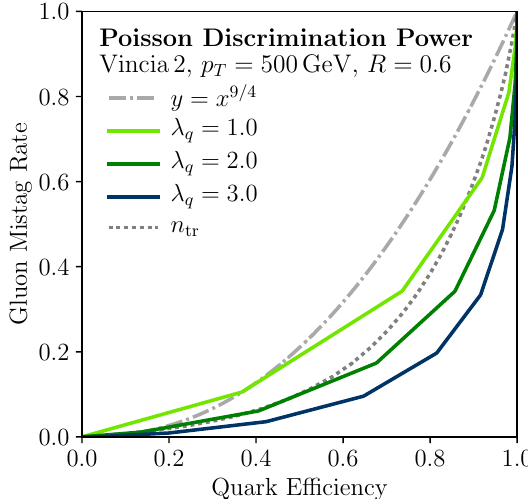
Figure 7. Expected quark/gluon discrimination power for Poisson-distributed observables. The mean observable value for quarks is (cid:21) q , and we assume the mean for gluons is given by Casimir scaling (cid:21) g = ( C A =C F ) (cid:21) q . For reference, we show the y = x 9 = 4 curve for additive observables with Casimir scaling, as well as track multiplicity n tr extracted from Vincia . For mean quark values (cid:21) q & 2, a Poisson-like observable satisfying Casimir scaling would be competitive with track multiplicity. The ROC curves are piecewise linear since the observable takes on discrete integer values.